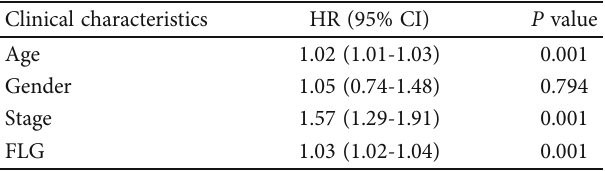
(a) Association with overall survival and clinicopathologic characteristics in TCGA patients using Cox regression Clinical characteristics